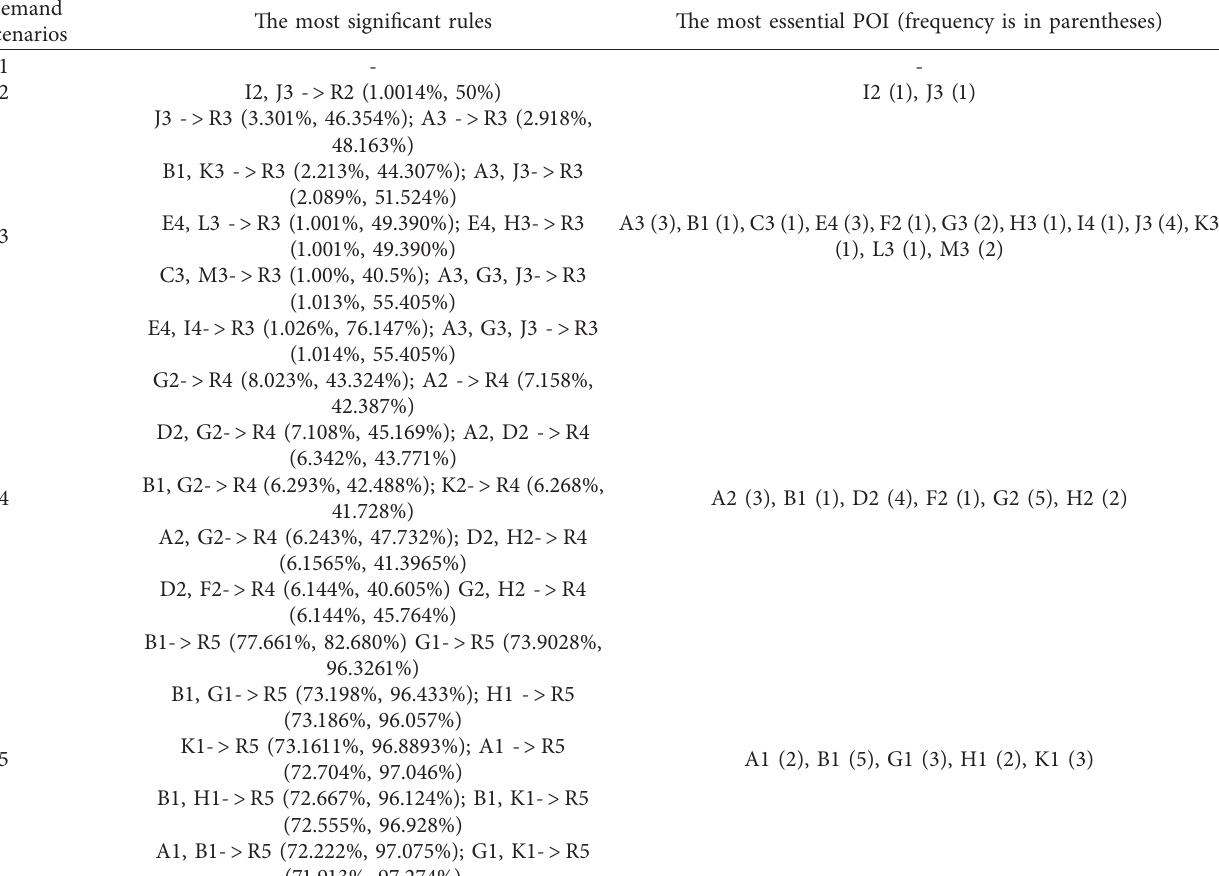
Table 7: The statistics of rules from Model 1.